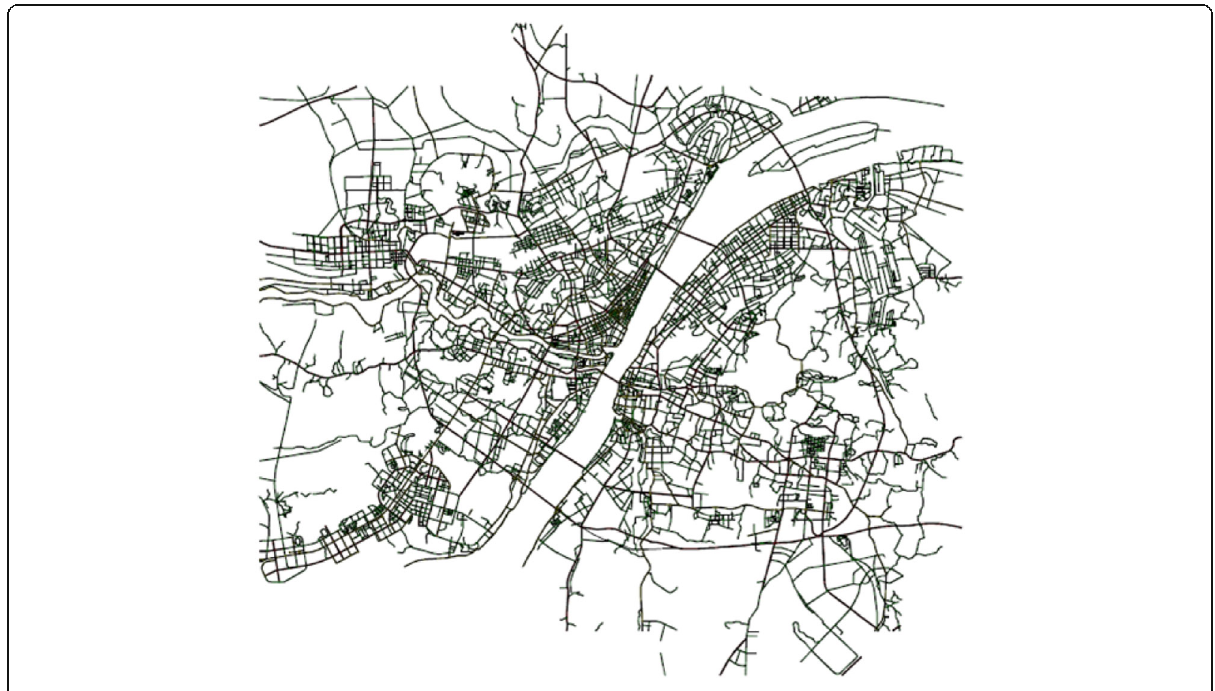
Fig. 10 Wuhan ’ s electronic map (2016)